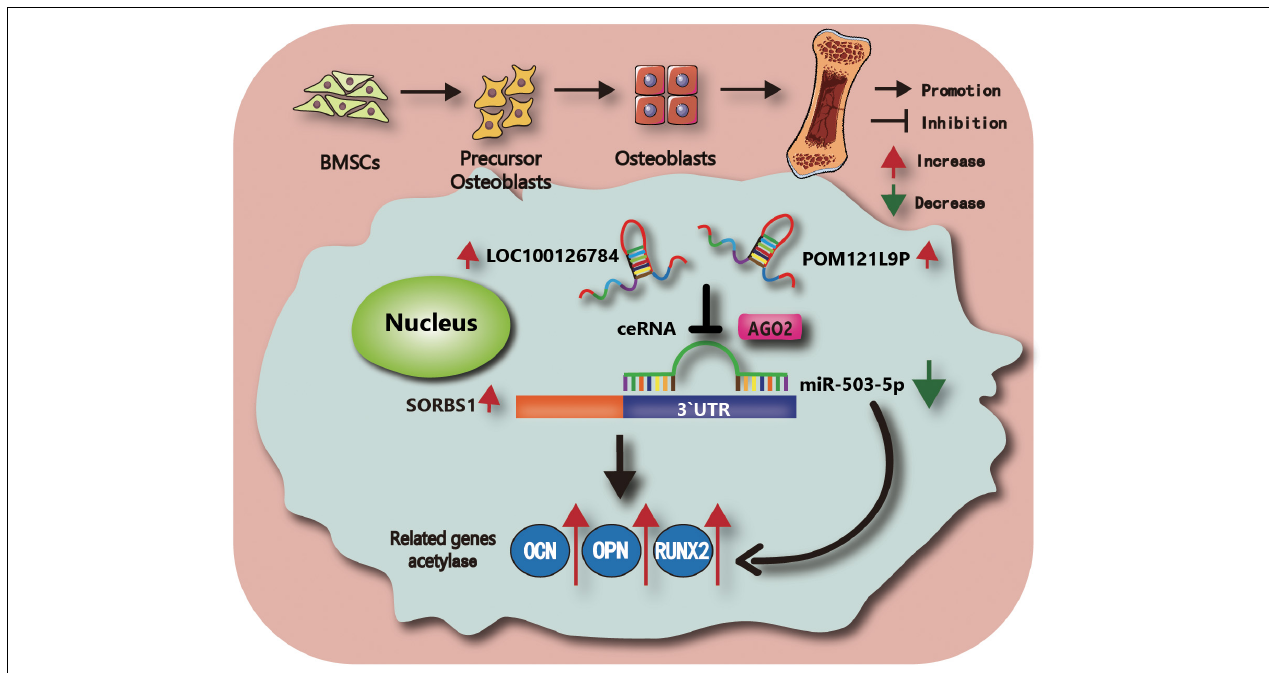
FIGURE 7 | Schematic illustration of the working hypothesis. We hypothesize that LOC100126784 and POM121L9P derived from BMSCs can enhance osteogenic differentiation. These effects can be fulfilled through competitively sponging miR-503-5p with the AGO2-mediated silencing complex to release